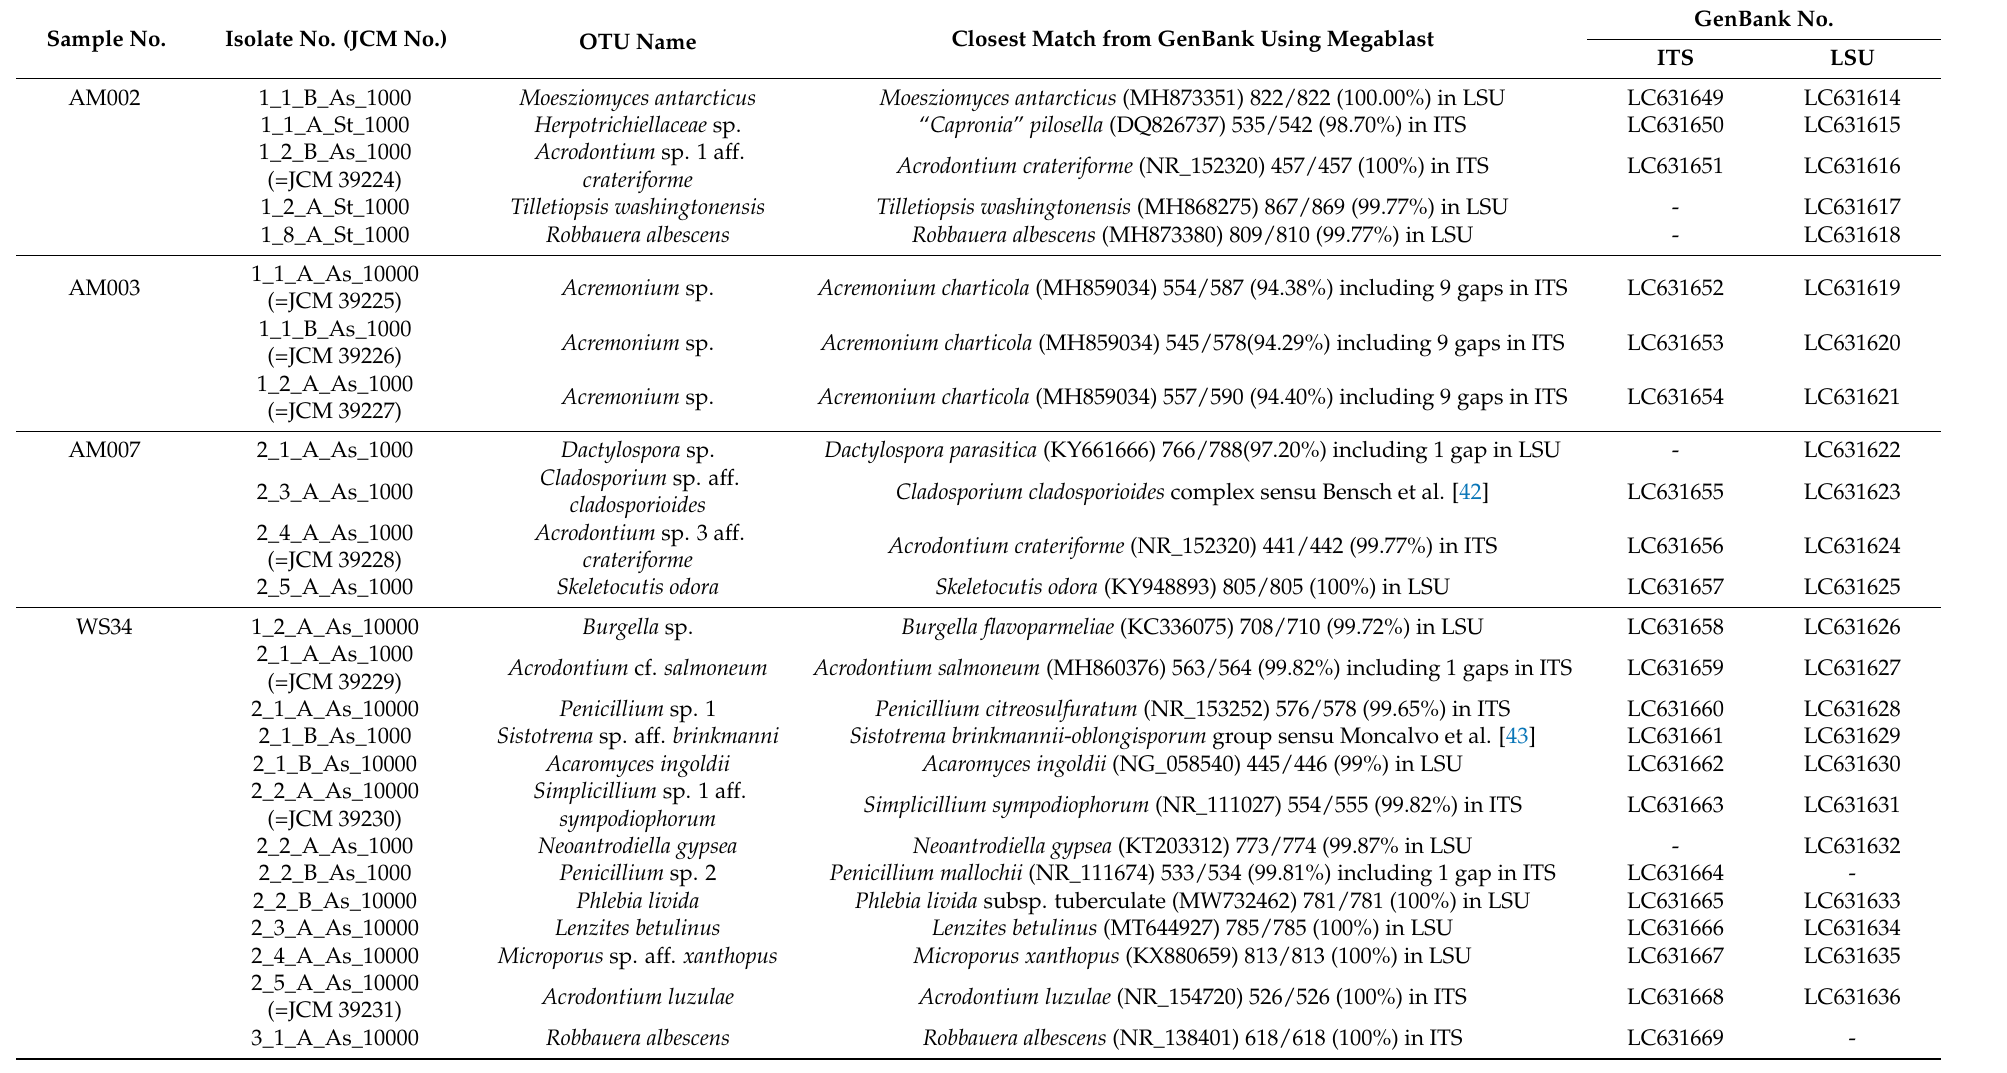
Table 2. Identification of the isolated fungi in this study using BLAST.